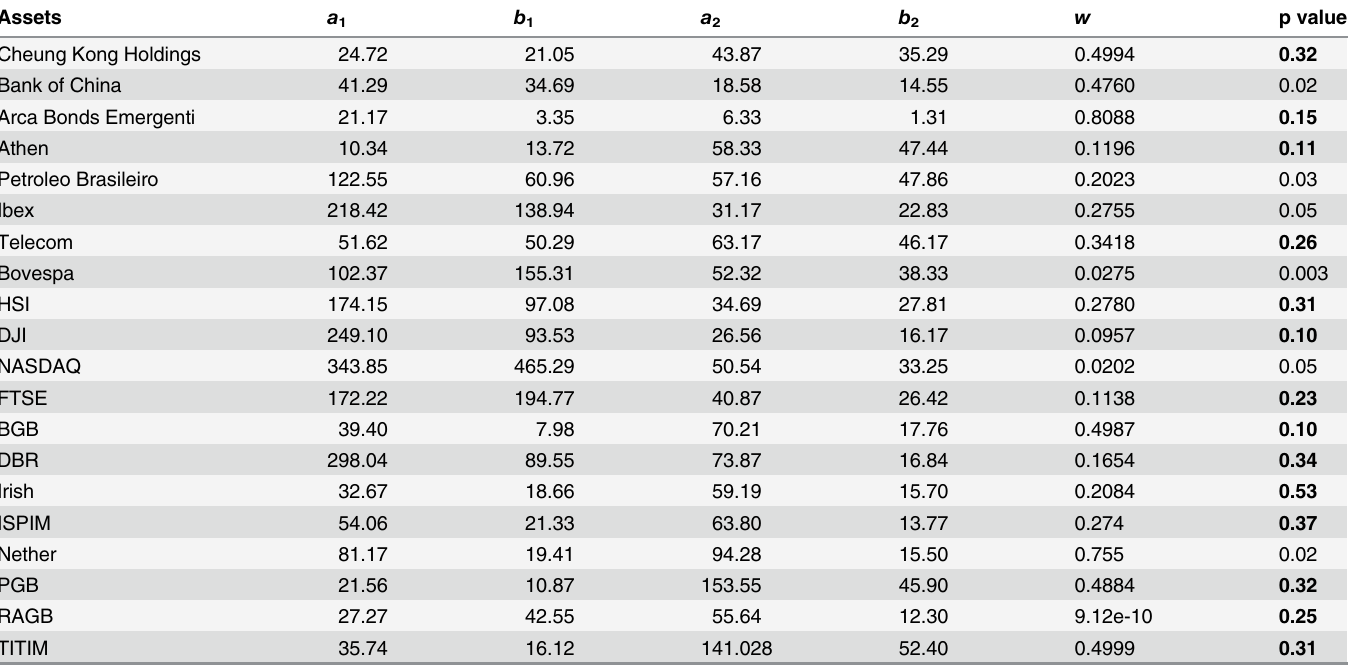
Table 1. K-S test results for single